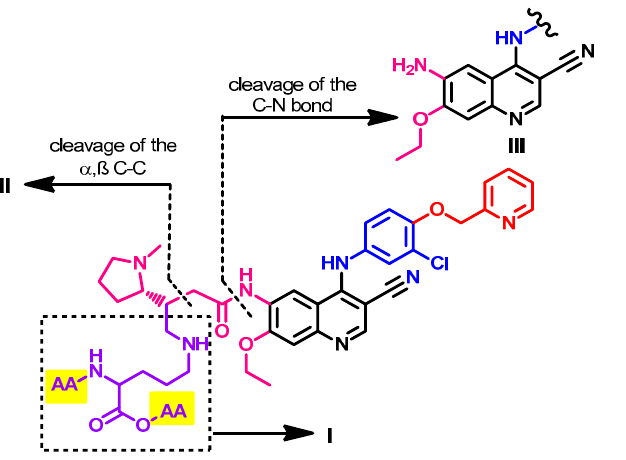
Figure 59. The proposed metabolic pathways of pyrotinib.